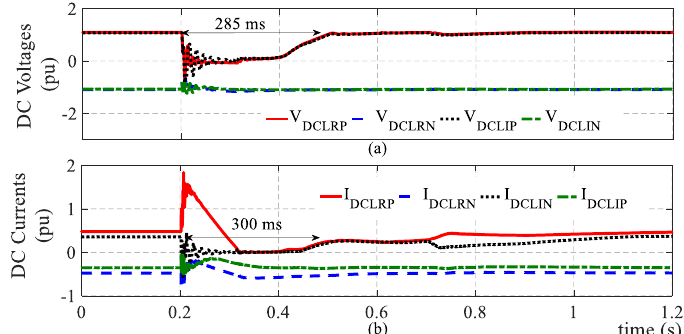
Figure 12. DC measurements at LCC stations for a P-Pole-to-ground fault on main transmission line ( a ) voltages, ( b ) currents.